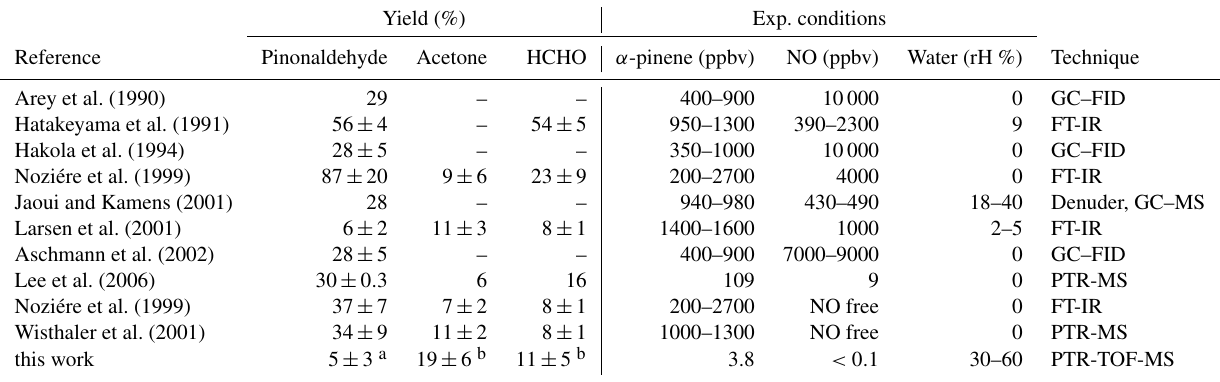
Table 2. Yields of pinonaldehyde, formaldehyde, and acetone for the reaction of α -pinene + OH compared to literature values. Experimental conditions and applied measurement technique for the detection of organic compounds are additionally listed.